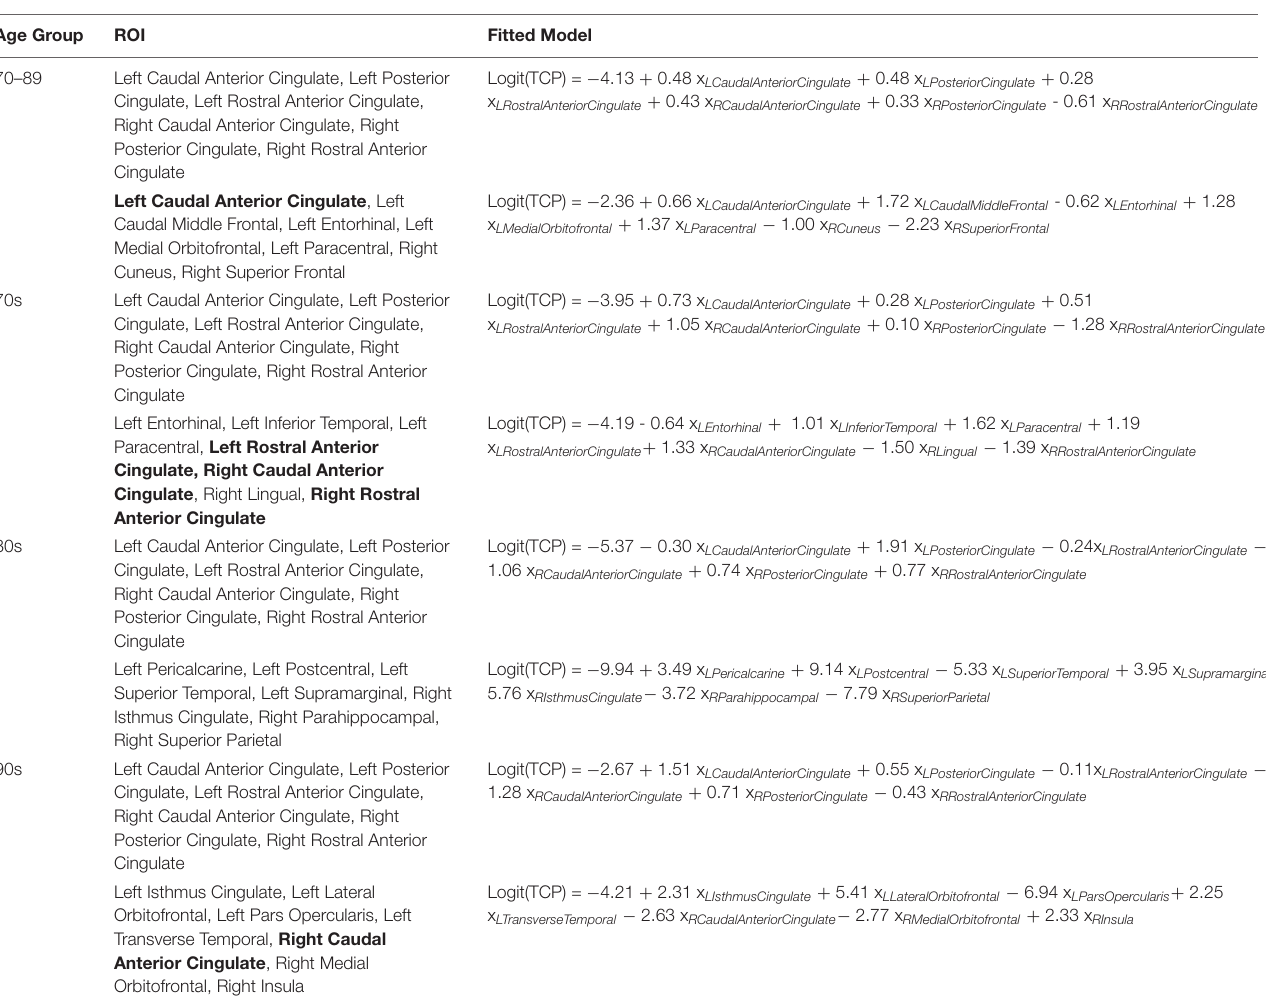
TABLE 3 | Fitted logistic regression models.